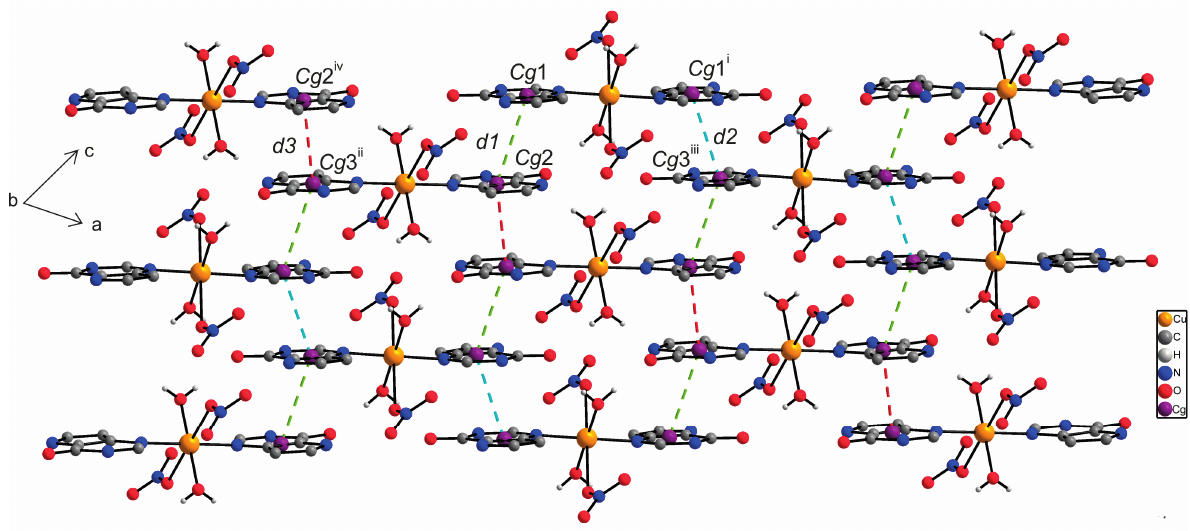
Figure 6. A perspective view (along the b axis) of the supramolecular structure of [Cu(9dhx) 2 (H 2 O) 2 (NO 3 ) 2 ] ( 2a ), showing the different distances of π ··· π interactions between the centroids of two adjacent 9dhx moieties, d1 { Cg 1··· Cg 2} = 3.6358(2) Å (green dashed lines), d2 { Cg 1 i ··· Cg 3 iii } = 3.4416(3) Å (blue dashed lines), and d3 { Cg 3 ii ··· Cg 2 iv } = 3.6542(2) Å (red dashes lines). Symmetry codes: (i) − x + 1, − y, − z + 1; (ii) − x, − y, − z; (iii) x + 1, y, z; (iv) x − 1, y,